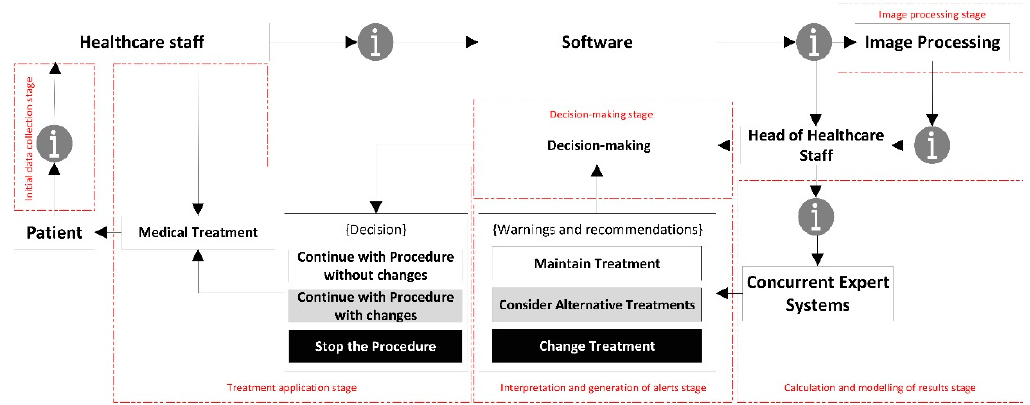
Figure 2. Stages of action in the proposed methodology.